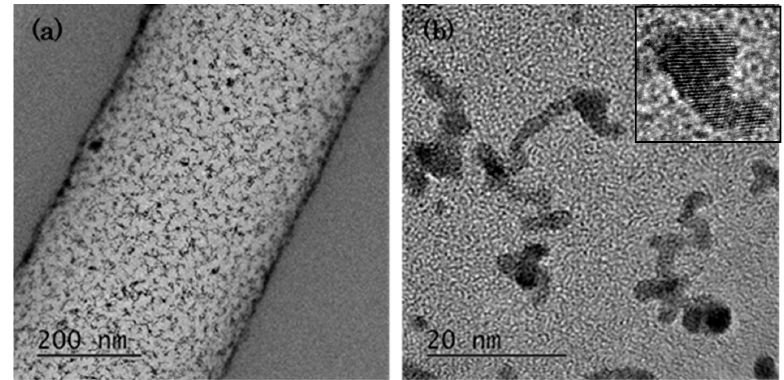
Figure 4. ( a ) Low- and ( b ) high-magnification cross-sectional TEM images of Pt nanoparticles precipitated into an ion-track-etched capillary in a heat-treated polyimide film.